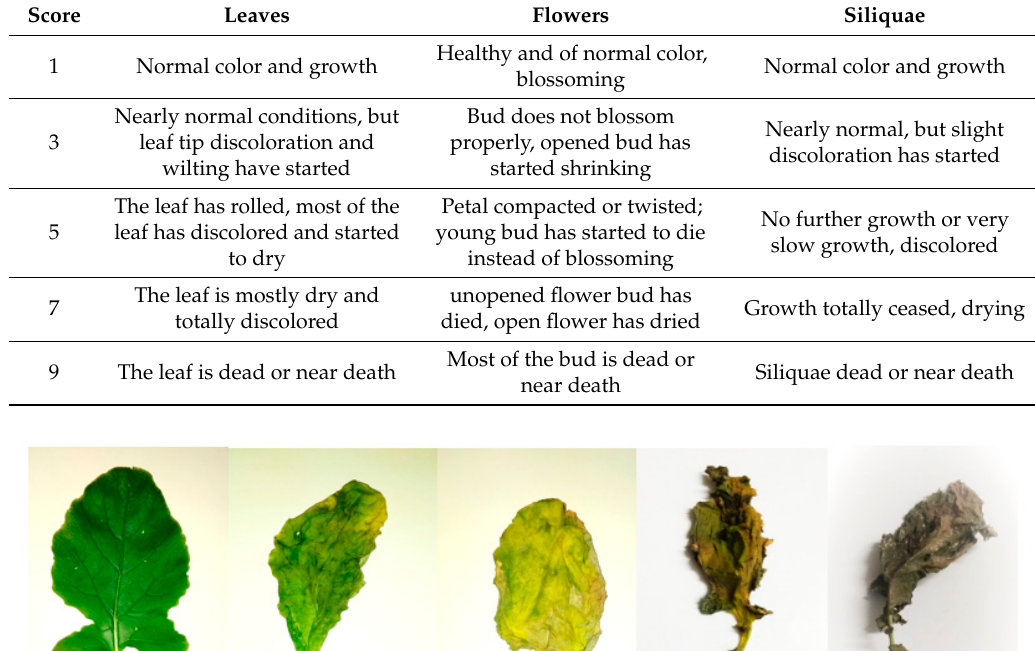
Table 1. Criteria for scoring visual salt injury in rapeseed at the reproductive stage.